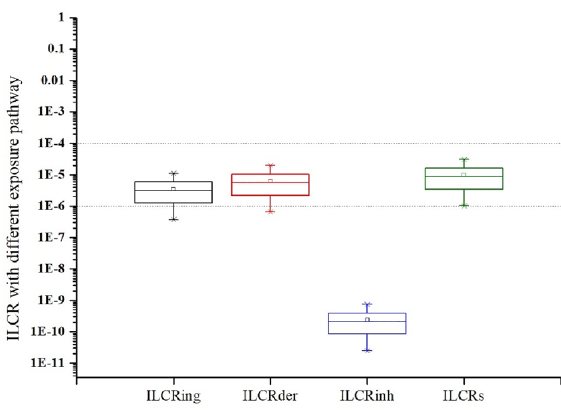
Figure 2. Distribution of ILCR with different exposure